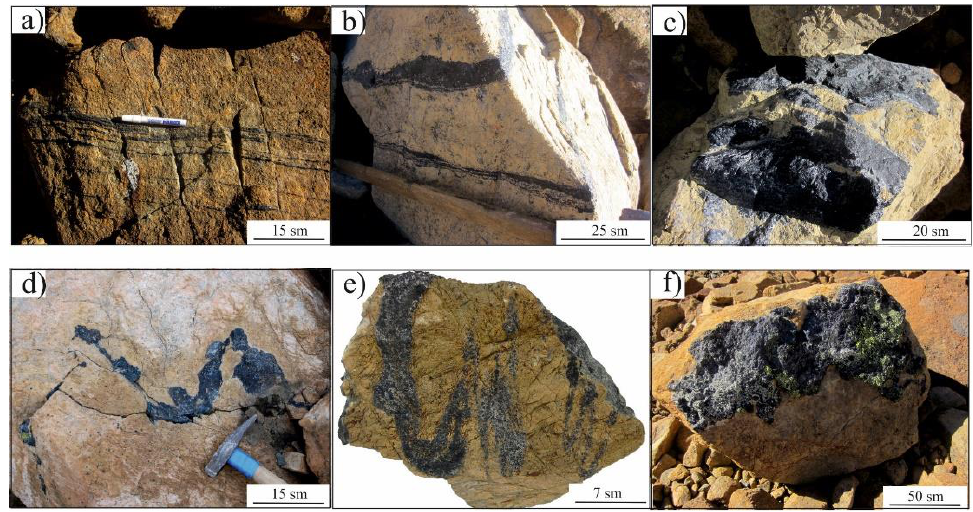
Figure 4. Structural features of chromitite pods: ( a ) chromitite seams in dunites; ( b ) schlieren; ( c ) massive pods; ( d ) transformation of the schlieren type into the massive type due to deformation processes; ( e ) folded schlieren-type chromitites; ( f ) structure of the “snowball”.